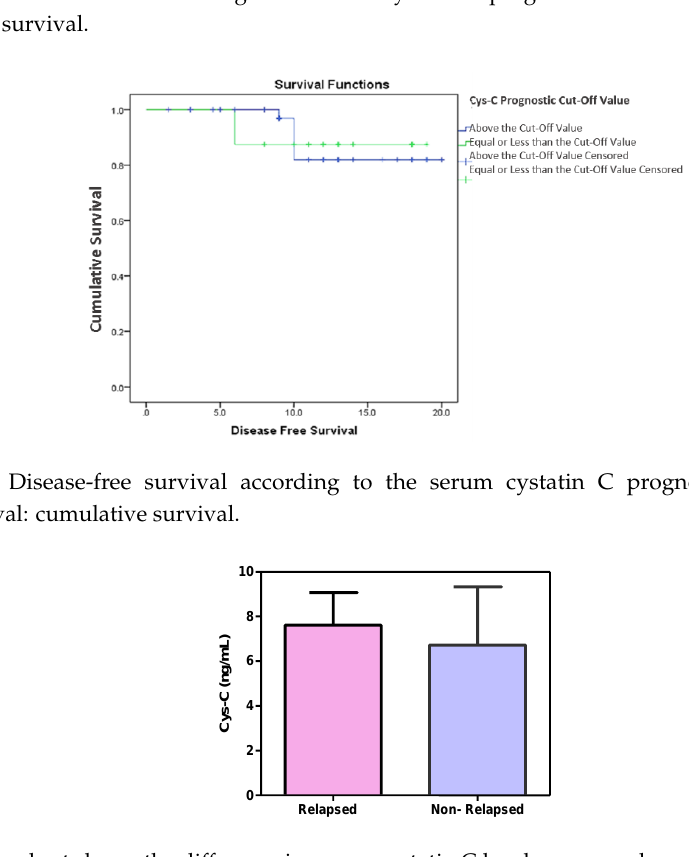
Figure 6. Bar chart shows the difference in serum cystatin C levels among relapsed and non-relapsed diffuse large B-cell lymphoma